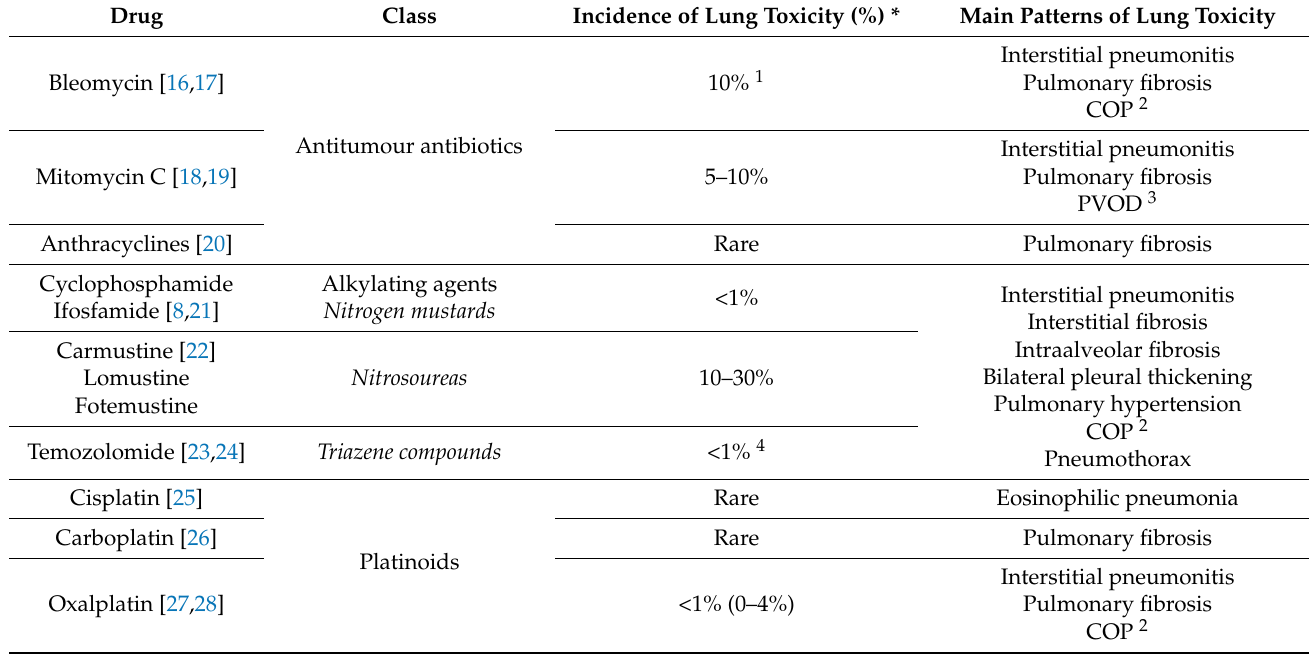
Table 1. Chemotherapeutic agents related to lung injury in the treatment of solid